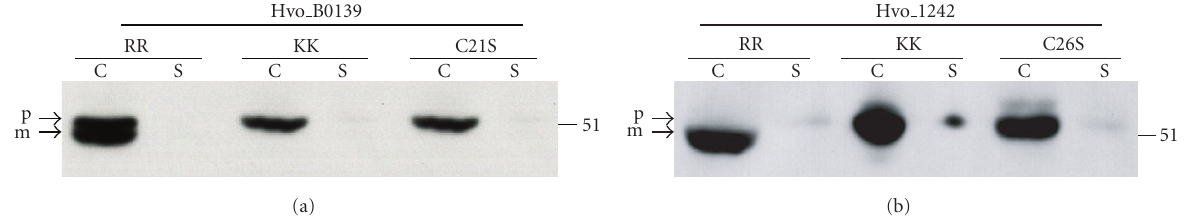
Figure 2: Hfx. volcanii proteins Hvo B0139 and Hvo 1242 are Tat substrates that require the lipobox cysteine for processing but not for anchoring to the cytoplasmic membrane. Western blot analyses of the wild-type (RR), twin lysine replacement mutants (KK), and cysteine to serine replacement mutants (C21S and C26S for Hvo B0139, and Hvo 1242, resp.). All proteins expressed had C-terminal Myc-tags and were detected using anti-Myc antibodies. Comparable amounts of protein were loaded in each lane. The migration of molecular weight standards is indicated on the right. Predicted positions of precursor (p) and mature (m) proteins are